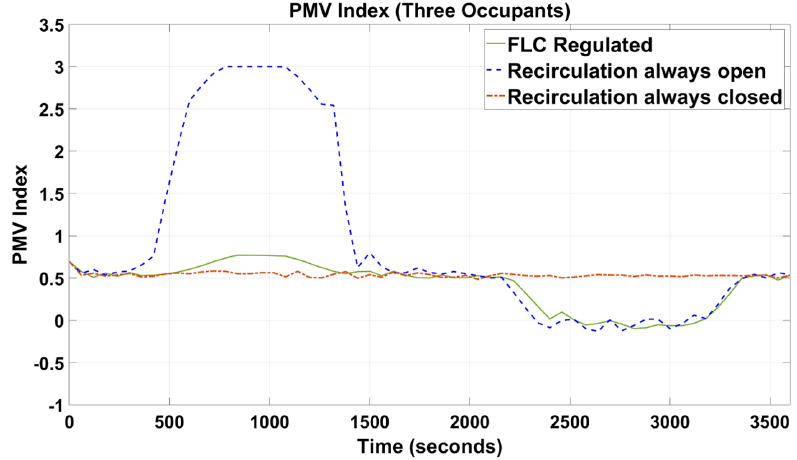
Figure 5. PMV index of the simulated vehicle cabin with one occupant.